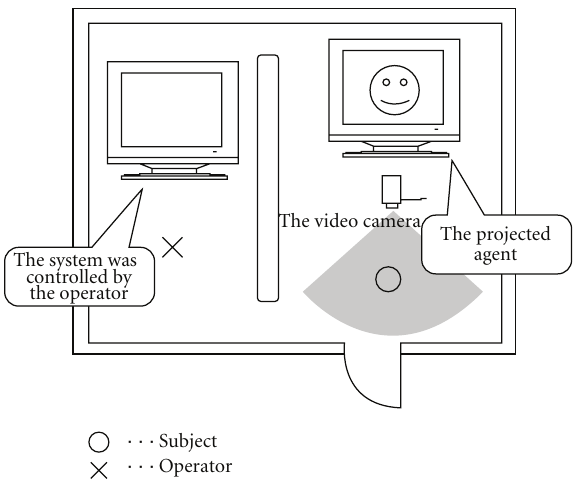
Figure 2: The experimental environment.